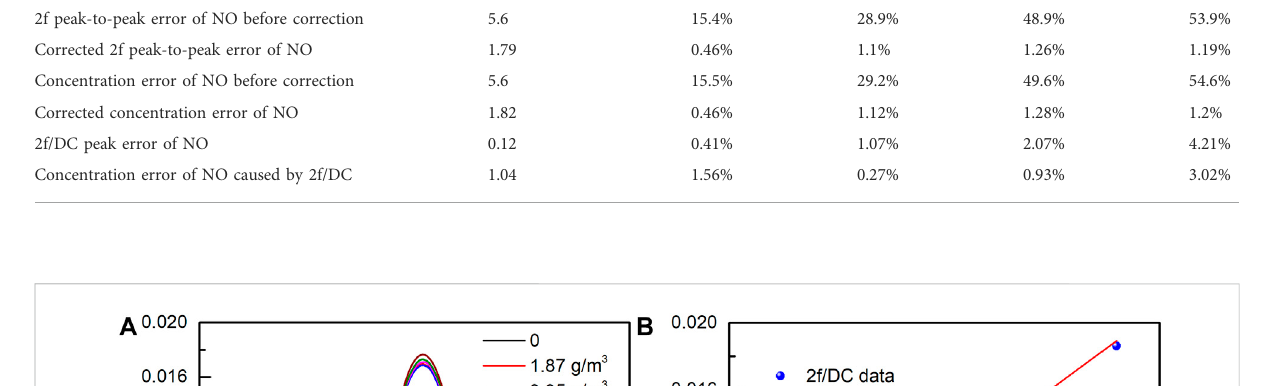
TABLE 2 2f peak-to-peak error and concentration error of NO before and after correction. Fly ash mass concentration g/m 3